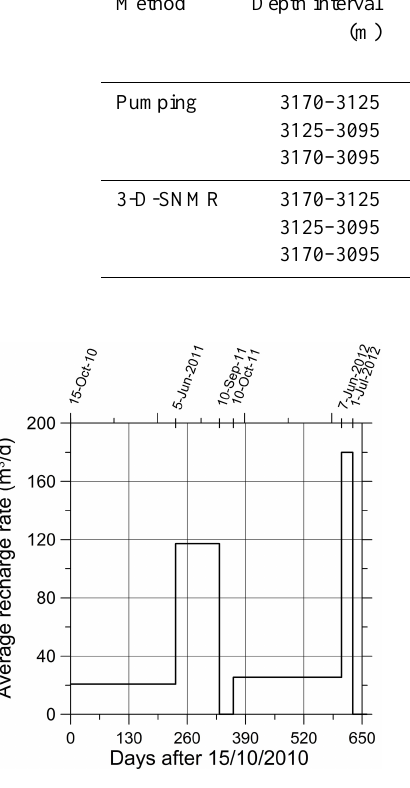
Fig. 13. Estimated average recharge rate of the cavern in the Tête Rousse glacier for the period between 15 October 2010 and 1 Au- gust